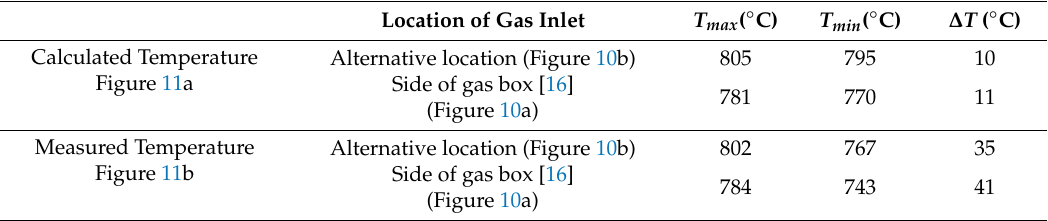
Table 2. Temperature comparison between di ff erent locations of hydrogen gas inlet by neglecting 20 mm from each sides.